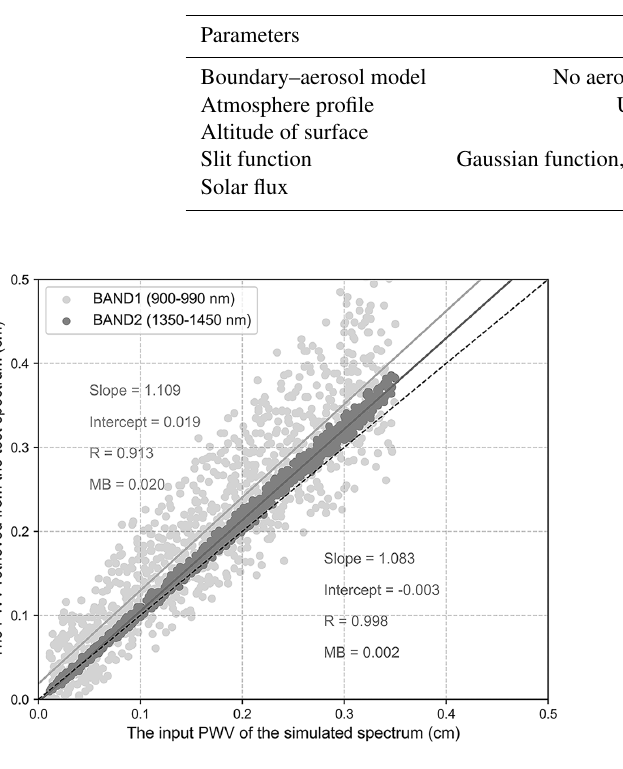
Figure 5. Scatter plot of the PWV retrievals obtained from BAND1 and BAND2 of the test spectrum versus the input PWV of the sim- ulated spectrum and their linear fits.